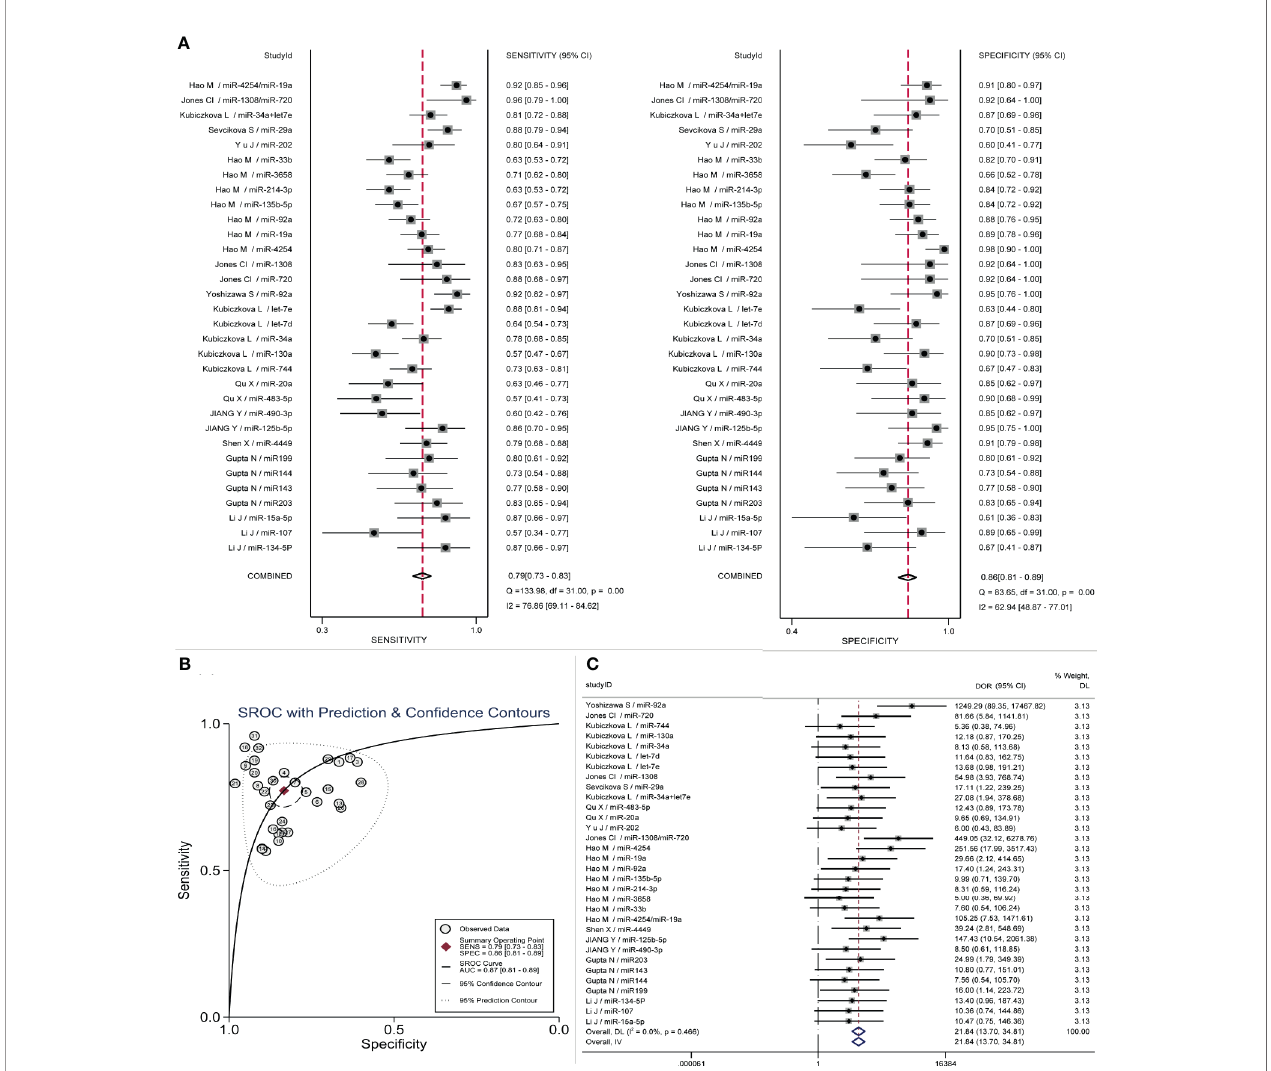
FIGURE 3 | Pooled diagnostic parameters of all microRNA studies. (A) Forest plot of Sensitivity and Speci fi city; (B) SROC curve; (C) Forest plot of